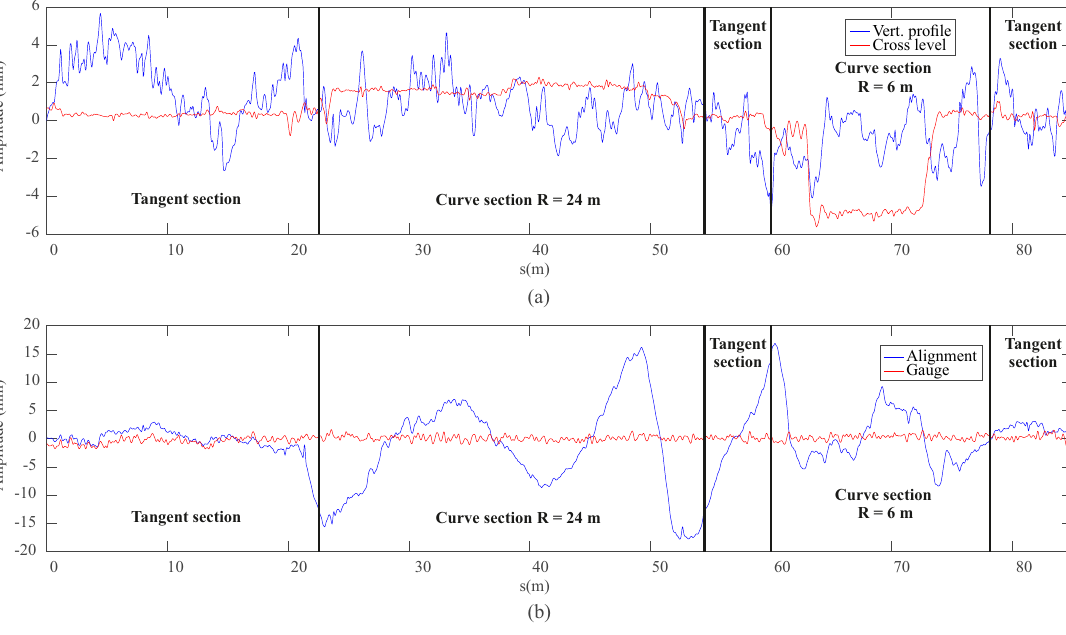
Figure 6. Vertical ( a ) and lateral ( b ) track